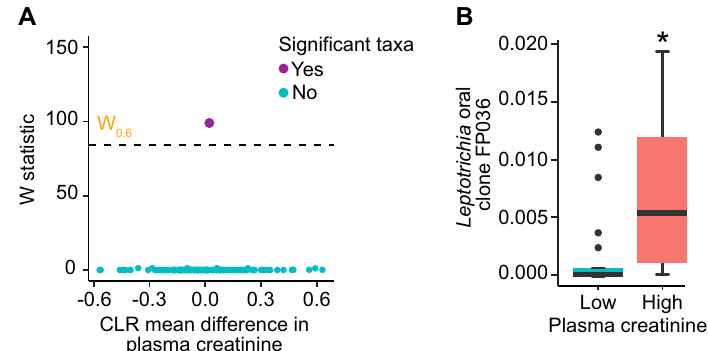
Figure 5. Several features in a linear mixed-effects analysis of composition of microbiomes (ANCOM-II)-based analysis of the cecal microbiome were used to identify taxa driving differences in plasma creatinine responses to polytrauma (PT) and hemorrhagic shock (HS). ANCOM-II volcano plots showing W-statistic against center-log ratio (CLR)-fold change differences between (A) low and high plasma creatinine levels, with non- significant taxa under the coefficient of concordance threshold of 0.6 (dashed-line) and significant taxa above the threshold. Structural zeros are points identified by ANCOM-II in peach; non-structural zeros, or taxa with non-infinity W-statistic values, are in blue. Relative abundances of (B) Leptotrichia oral clone FP036, indicated as a significant, non-structural zero taxon ( W -statistic: 99) in panel (A) . The bottoms and tops of boxes indicate the first and third quartiles, respectively; whiskers indicate the 1.5 interquartile range beyond the upper and lower quartiles. Values outside the whiskers are indicated by black circles. ANCOM-II analysis of composition of microbiomes II, CLR center-log ratio, HS hemorrhagic shock, PT polytrauma